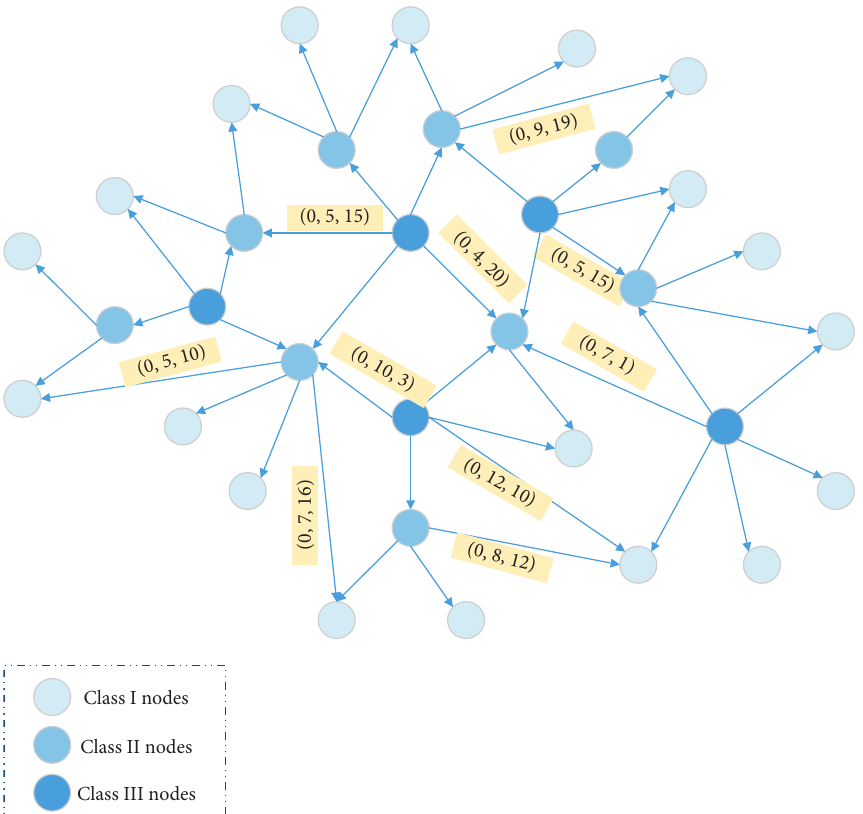
Figure 2: Schematic diagram of cross-border e-commerce logistics network